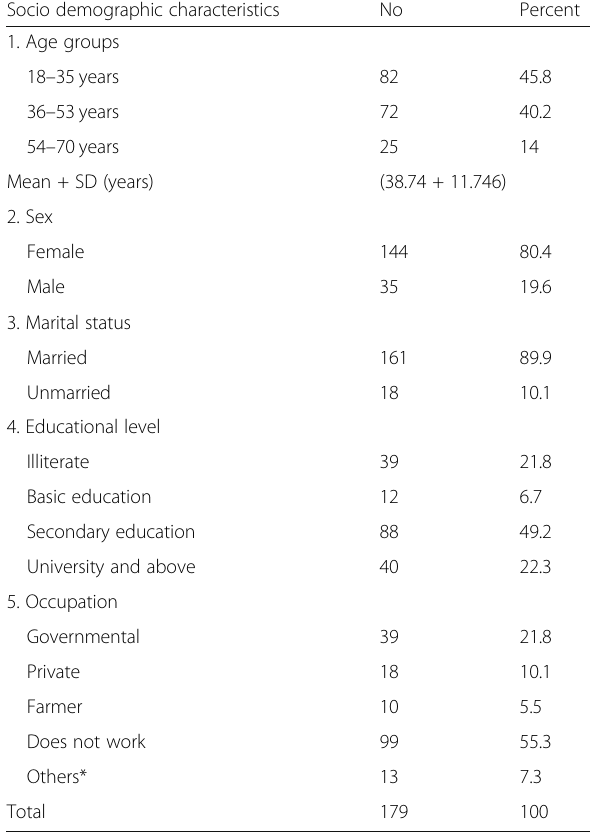
Table 1 Distribution of the study participants regarding their sociodemographic characteristics Socio demographic